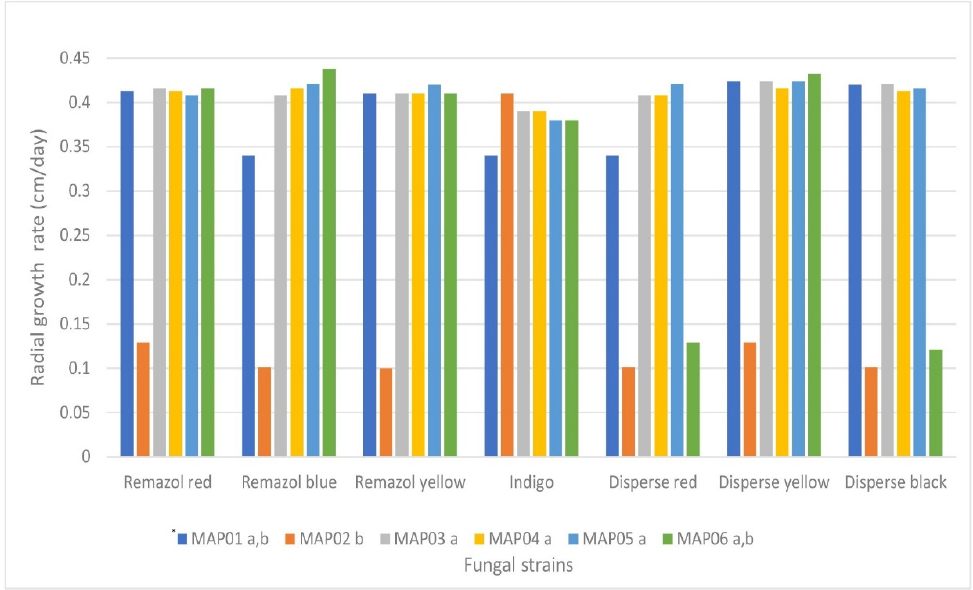
Figure 3. Radial growth rate (cm/day) of MAP strains grown for six days on agar media containing a carbon source and different dyes. * Strains with the same letters (a,b) are not significantly different at a 95% confidence interval.